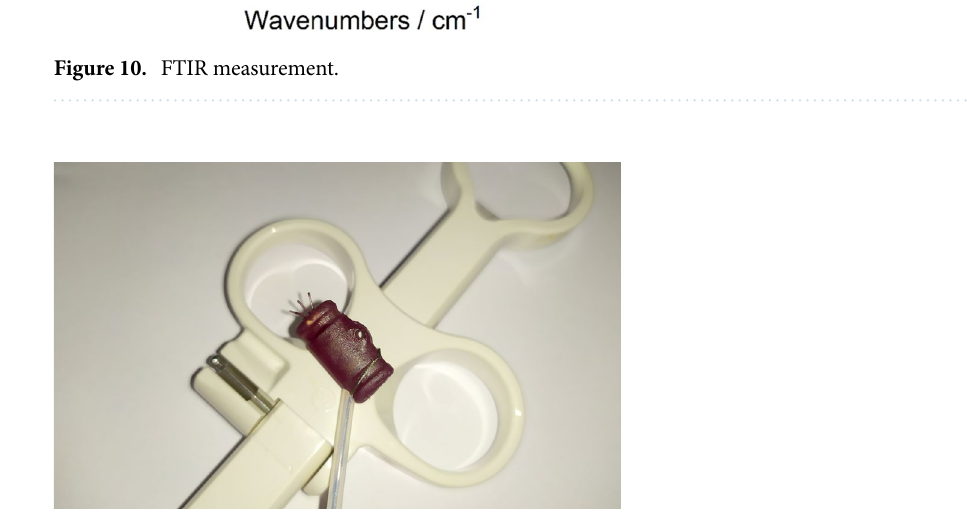
Figure 11. Example of a grasping feature embedded in the encapsulated